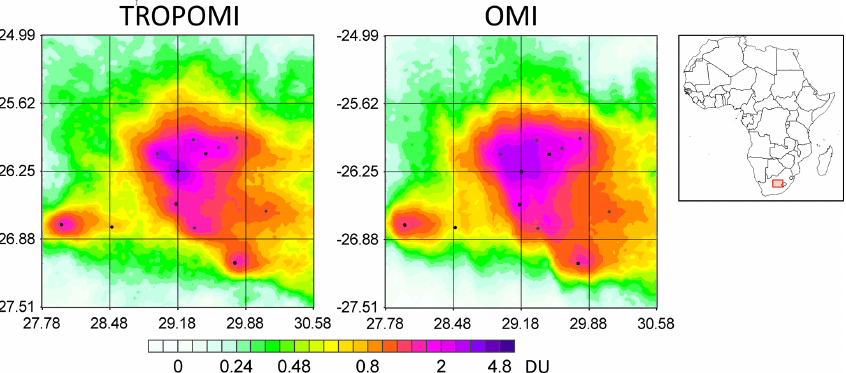
Figure 7. The mean TROPOMI SO 2 over a cluster of power plants in South Africa for the period from April 2018 to March 2019 and the mean 2005–2019 OMI SO 2 over the same region. Data are smoothed by oversampling/pixel averaging with R = 10km. The black dots indicate the emission sources. Note that the colour scale is different from the scale in the previous